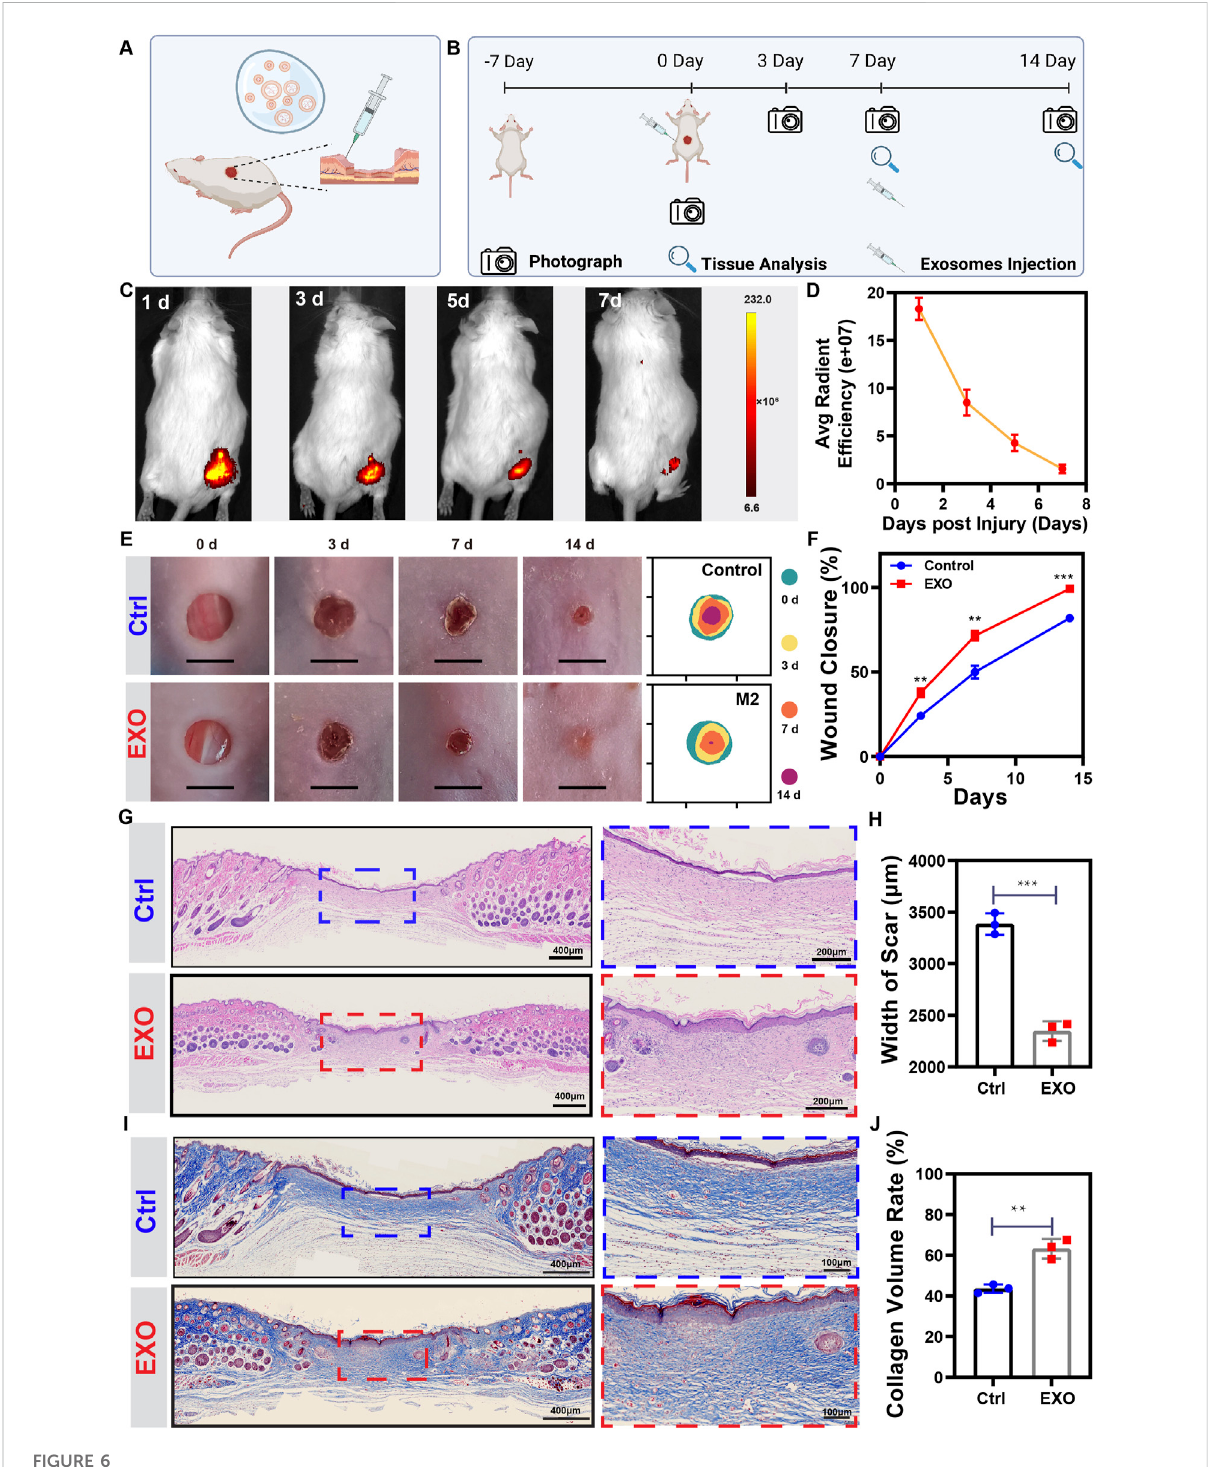
FIGURE 6 M2-EXO treatment promotes skin wound healing in mice. (A,B) Schematic of animal surgery and schedule for animal study. Created with BioRender.com. (C,D) IVIS images of Dir-labeled exosomes injected mouse. Images were collected from the same individual mouse. The average fl uorescence ef fi ciency was managed and analyzed by Living Image software. ( n = 4). (E,F) The gross view and healing trace of the wound in control and M2-EXO treated groups. Images and healing traces were collected from the same mouse randomly chosen from the control and the M2- EXO treated group. The wound closure rate was analyzed according to the healing trace. ( n = 3). (G) Representative fi gures of HE staining wound. Scale bar was labeled in the fi gure. (H) Width of scar. ( n = 3). (I) Representative fi gures of Masson staining wound. Scale bar was labeled in the fi gure. (J) Quantitative analysis of collagen volume in each group. ( n = 3). Data was expressed as mean ± 3 σ ; * = signi fi cant, * p < 0.05; ** p < 0.01,*** p < 0. 005; **** p < 0.001, Student t